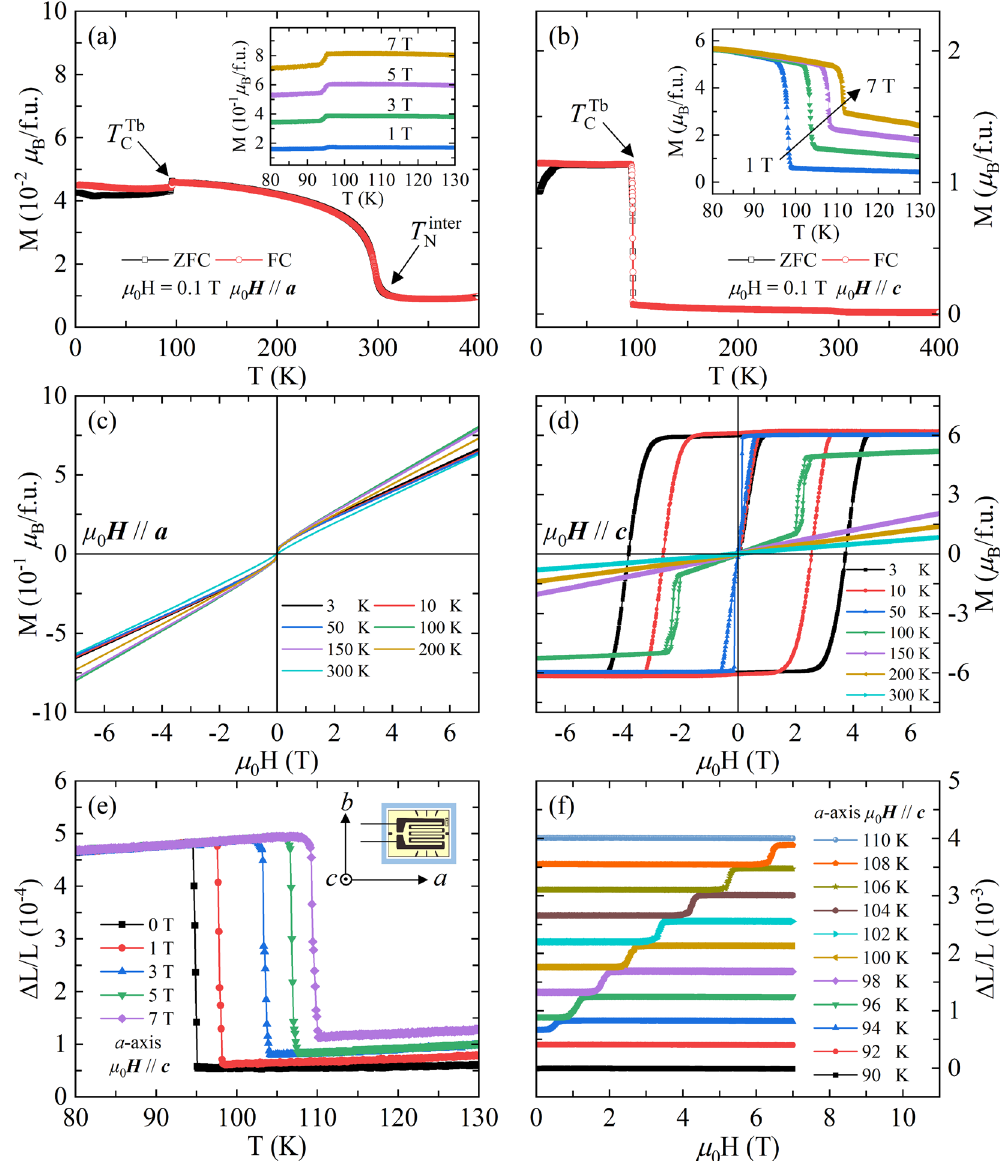
Figure 2. Temperature dependence of ZFC and FC magnetization measured with μ 0 H = 0.1 T along ( a ) a and ( b ) c axes. The insets of ( a ) and ( b ) show the FC curves with various magnetic fields near T Tb C . ( c ) and ( d ) show the isothermal magnetic hysteresis loops from 3 to 300 K with μ 0 H // a and μ 0 H // c , respectively. ( e ) Temperature dependence of the strain change along a axis with μ 0 H // c . The inset shows the schematic of the strain gauge and the sample. ( f ) Magnetic field dependence of magnetostriction [ΔL/L = ΔL/L(H) − ΔL/L(0)] along a axis with μ 0 H // c at different temperatures. For clarity, the curves are shifted upward except for the result with T = 90